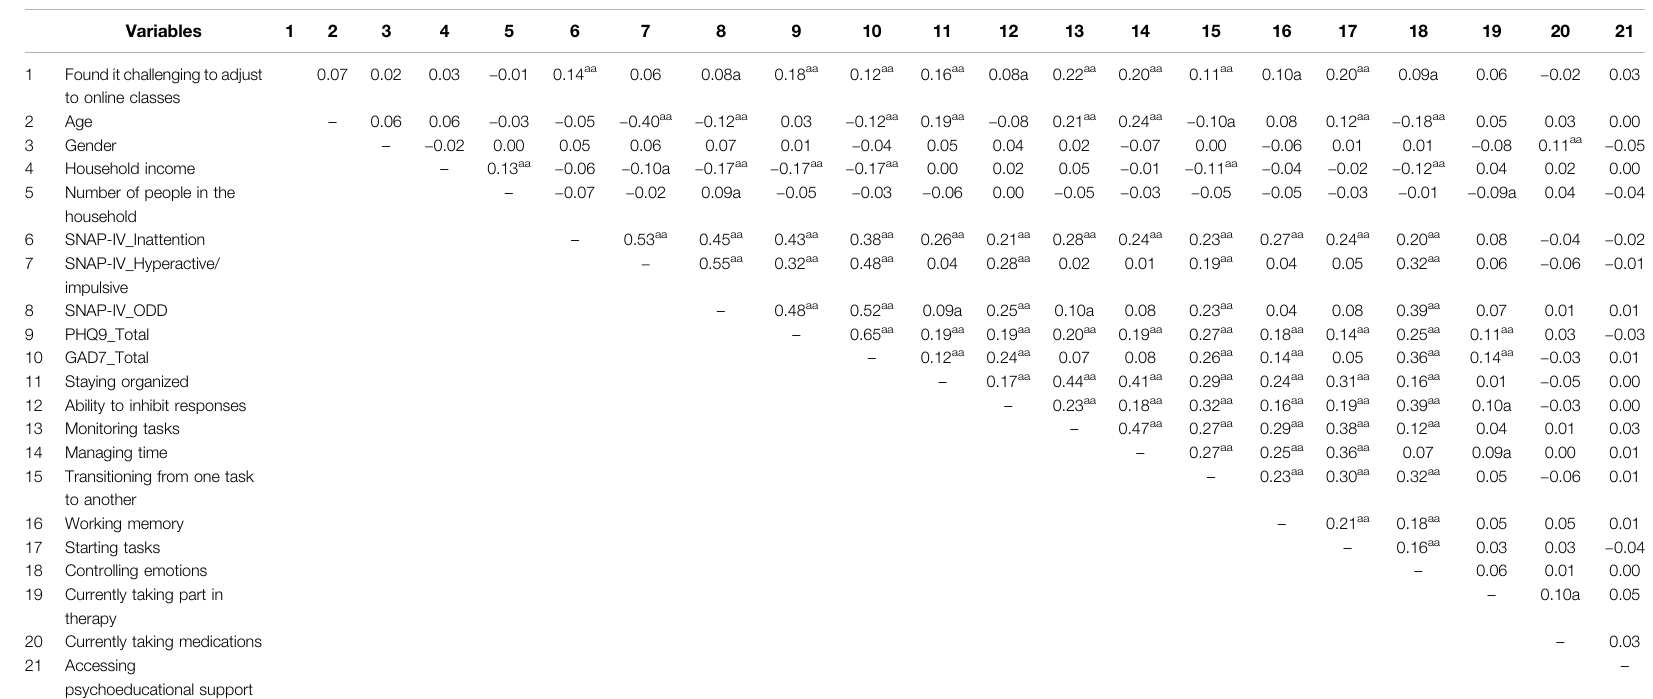
TABLE 4 | Correlates of Educational Changes due to COVID-19 pandemic.